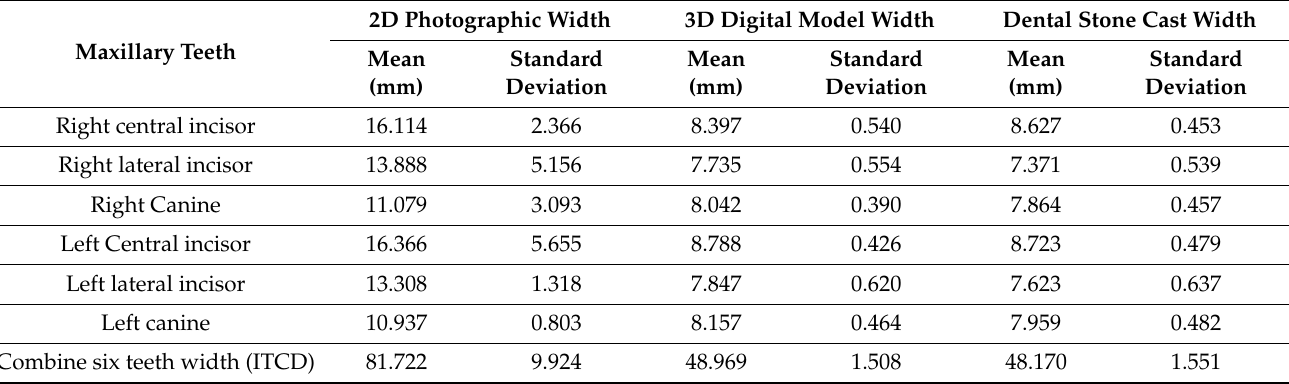
Table 2. The distribution of mean maxillary anterior teeth widths obtained from 2D photographs, 3D models, and dental stone cast ( n = 230).